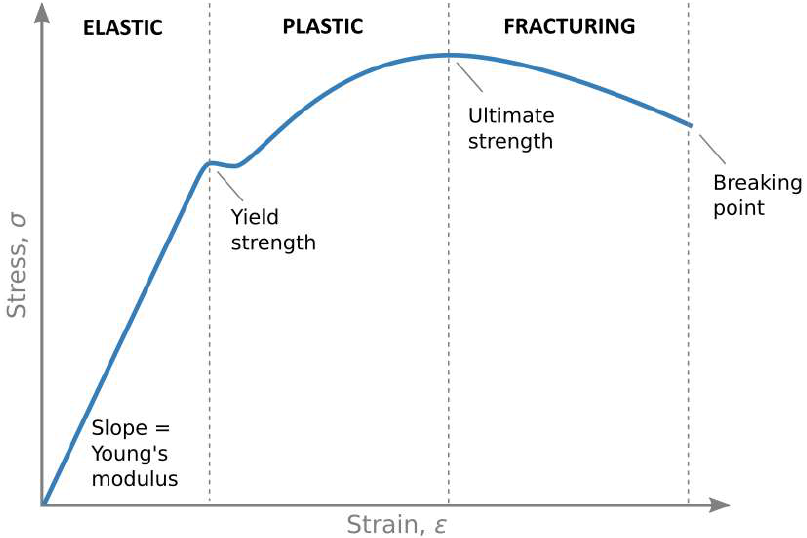
Figure 2. Schematic stress–strain diagram for an elastoplastic solid. A brittle solid typically shows just an approximately linear stress–strain curve up to failure, i.e., yield strength, ultimate strength, and breaking strength coincide at strains of <5%.